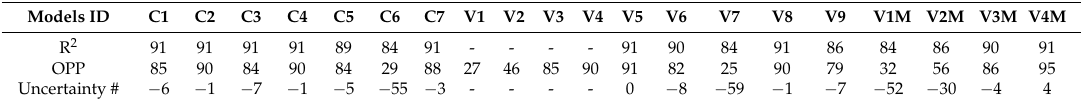
Table 5. A comparison of the models’ adequacy and overall prediction performance. Models ID